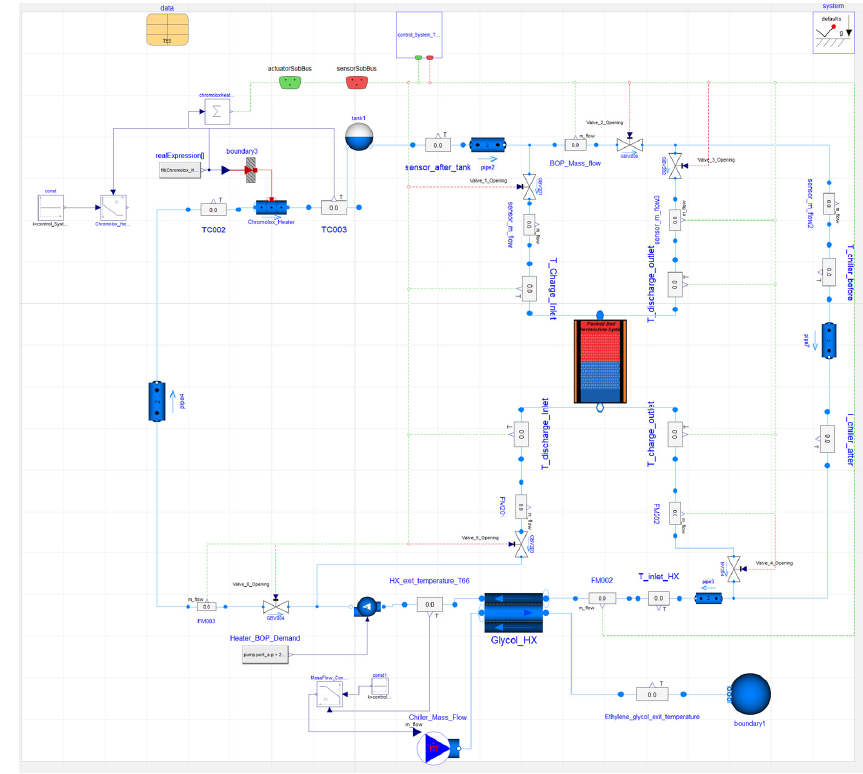
Figure 9. Modelica TEDS model.